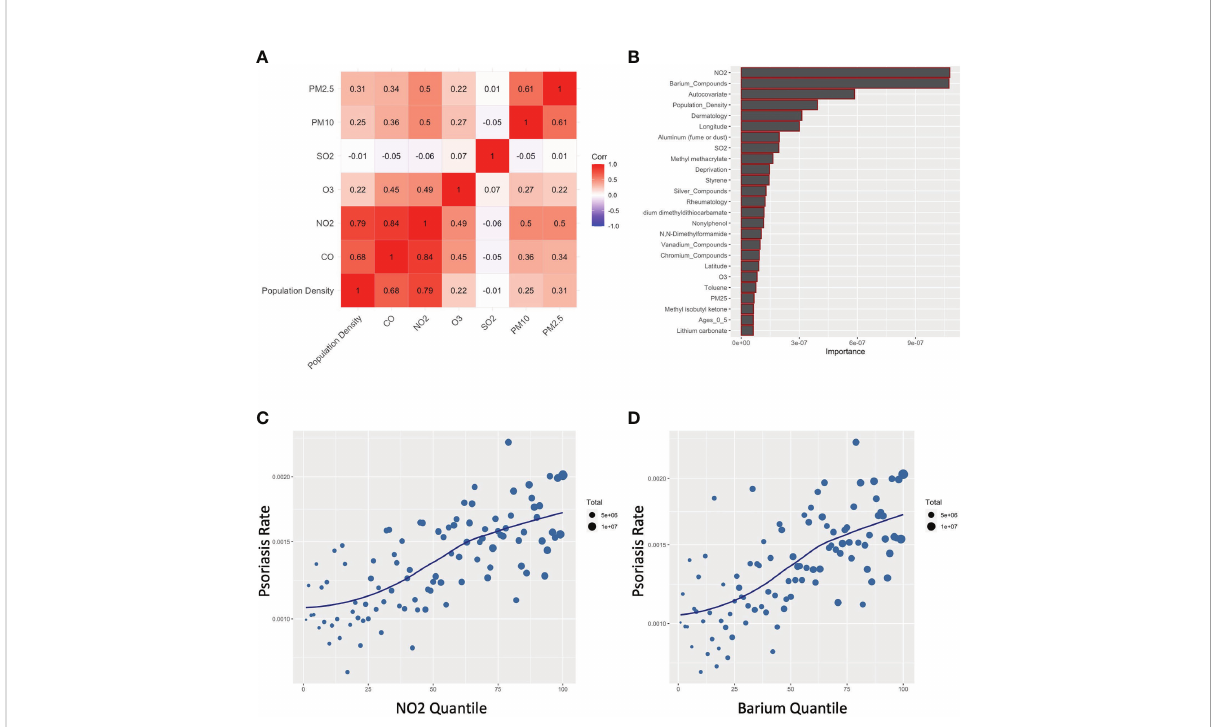
FIGURE 4 Carbon monoxide associates with other common air pollutants for psoriasis. (A) Correlogram for indicated pollutants. (B) Random forest assessment accounting for non-linearities and complex interactions (C, D) Percentile plots for concentration of NO2 (C) and barium (D) against rates of